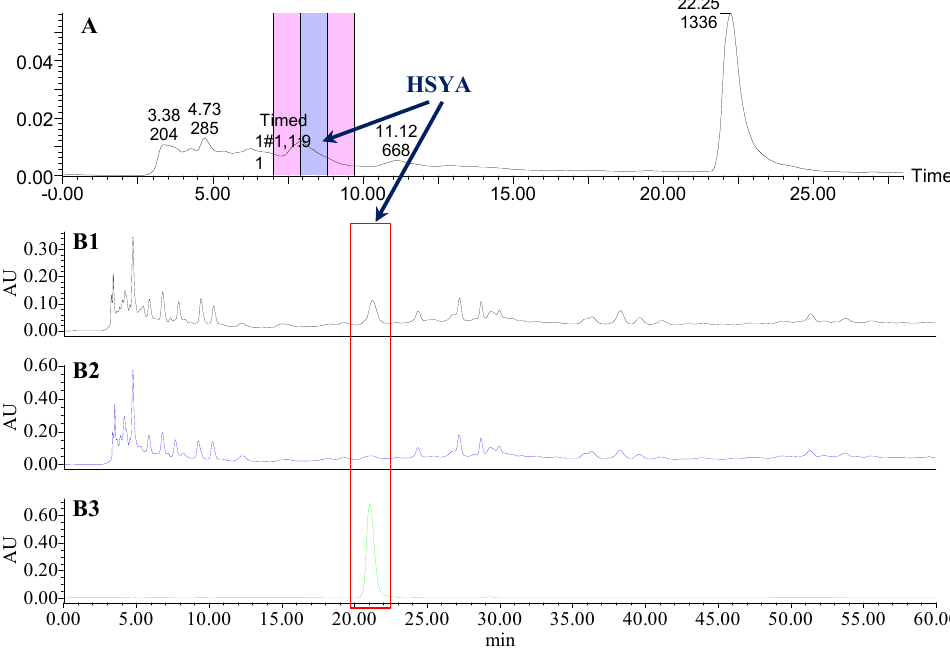
Figure 4. The preparative and analytical chromatograms of the depletion of HSYA from CF-AR; ( A ) preparative chromatogram at 270 nm; ( B1 ) analytical chromatogram of CF-AR at 270 nm; ( B2 ) analytical chromatogram of CF-AR-A at 270 nm; ( B3 ) analytical chromatogram of HSYA depleted from CF-AR at 270